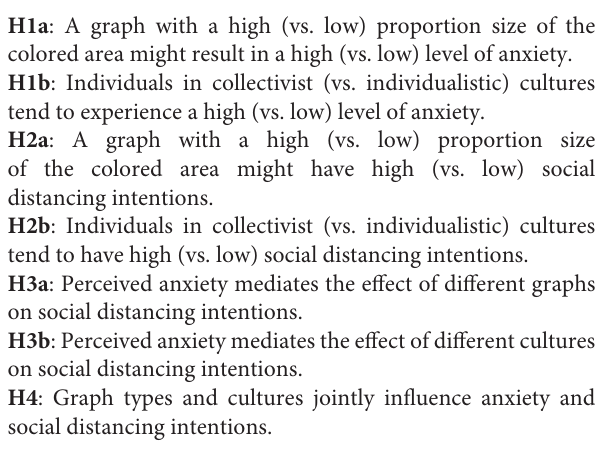
FIGURE 2 | Theoretical model of this